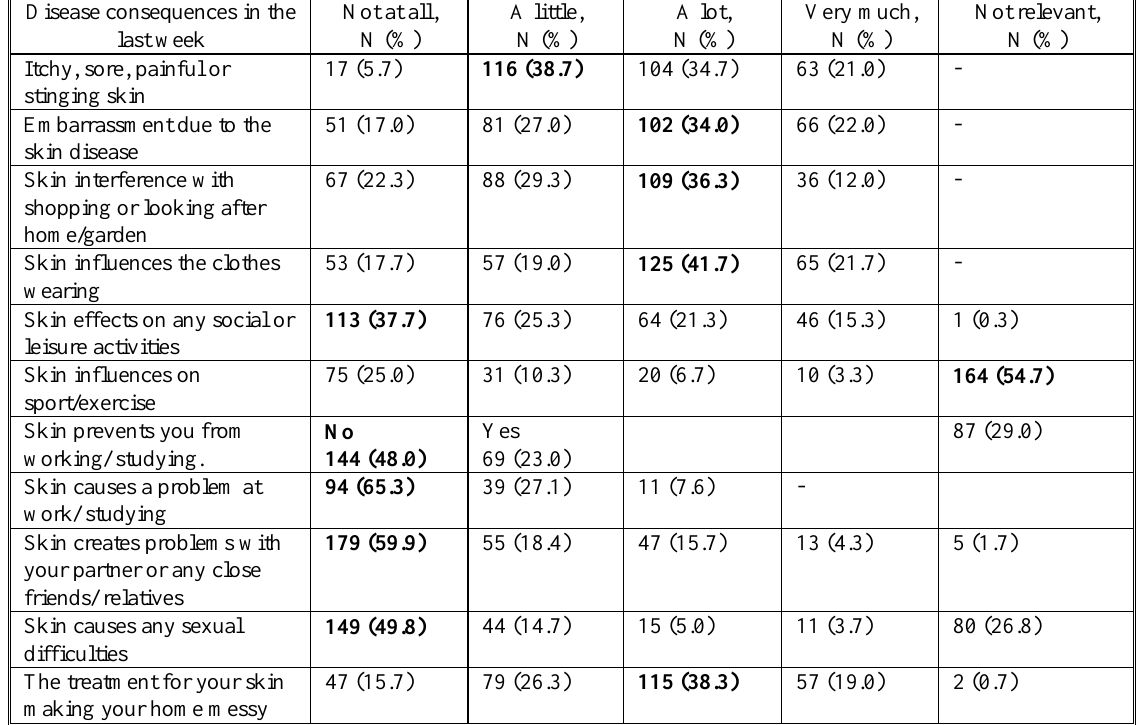
Table 5. Patients answers to dermatology Life Quality Index (DLQI) Disease consequences in